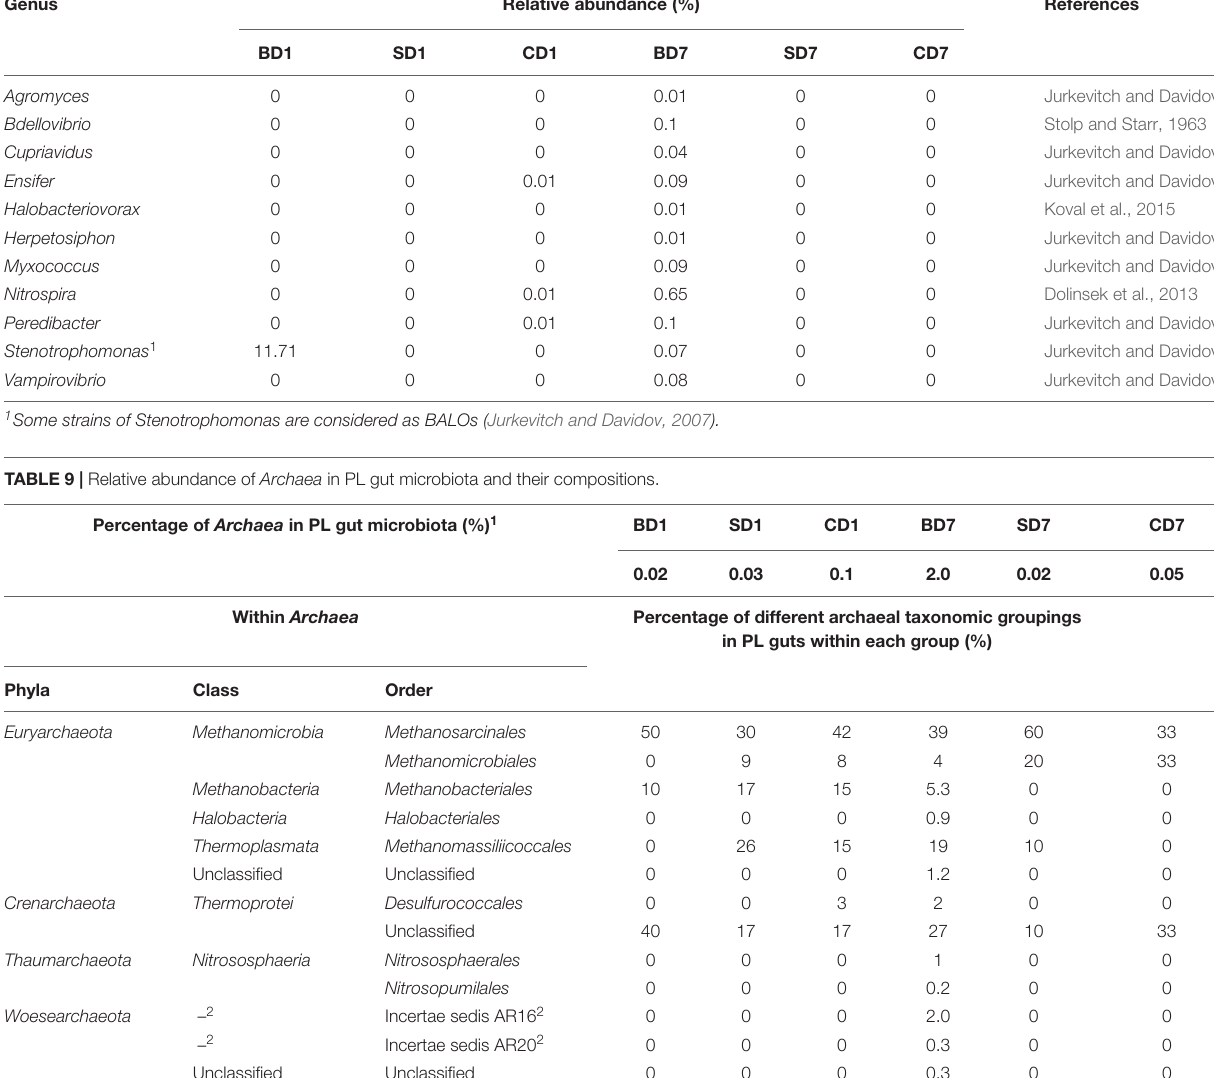
TABLE 8 | Relative abundance of genera being recognized in the BALOs grouping. Genus Relative abundance (%)